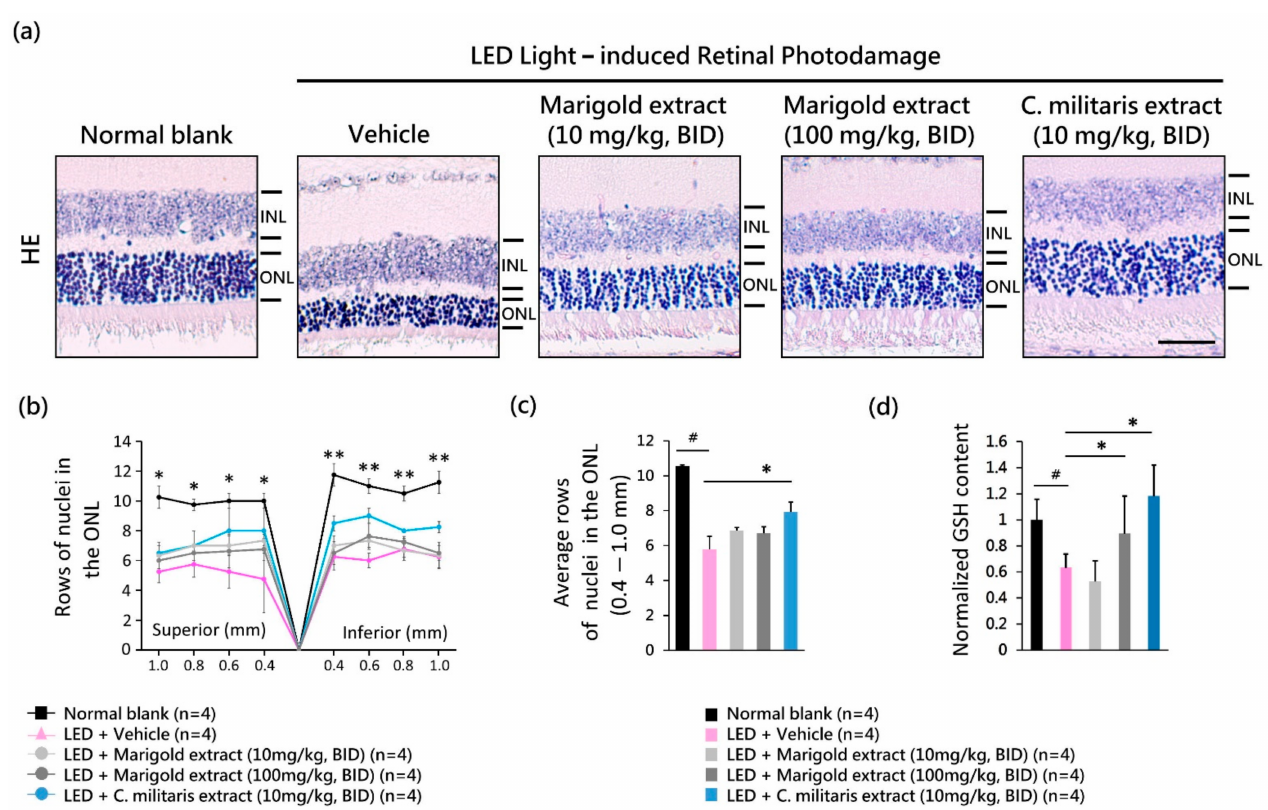
Figure 5. Antioxidant protective effect of C. militaris extract. ( a ) Hematoxylin and eosin staining representing the layers of ONL nuclei; ( b ) change of ONL nuclei within 0.4~1.0 mm superior and inferior to the optic nerve; ( c ) average ONL nuclei; ( d ) normalized GSH level. Data are expressed as mean ± SE. A Mann-Whitney U test was performed. # : p < 0.05, *: p < 0.05, **: p < 0.01. Scale bar: 35 µ m. INL: the inner nuclear layer; ONL: the outer nuclear